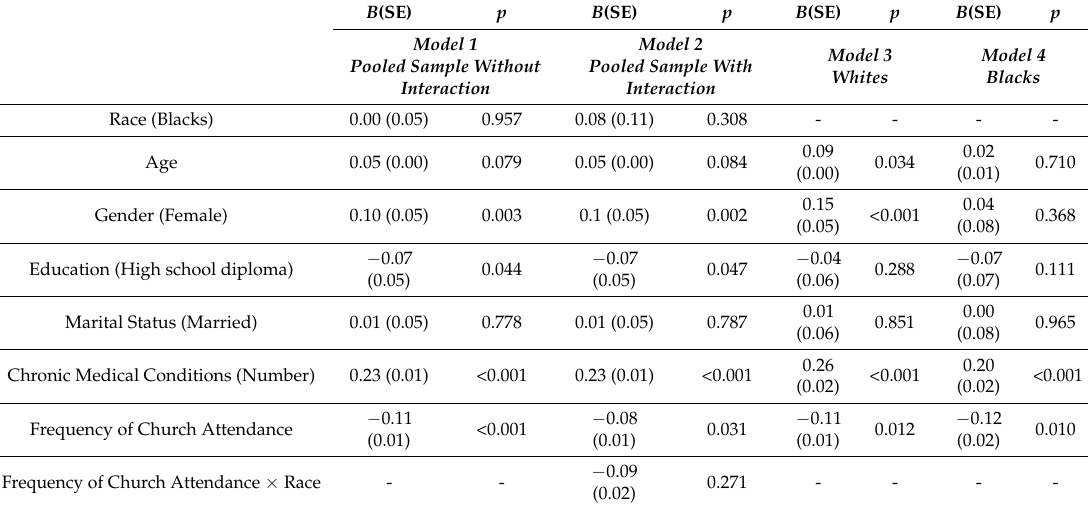
Table 2. Effects of church attendance on depressive symptoms based on race in older adults using linear regressions.